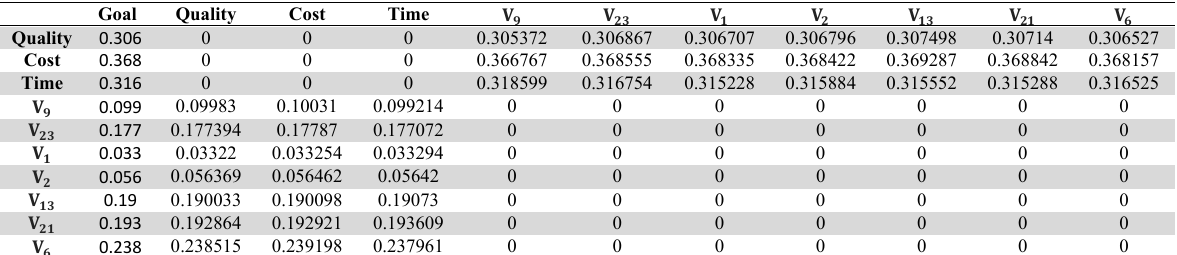
The final matrix of ANP results